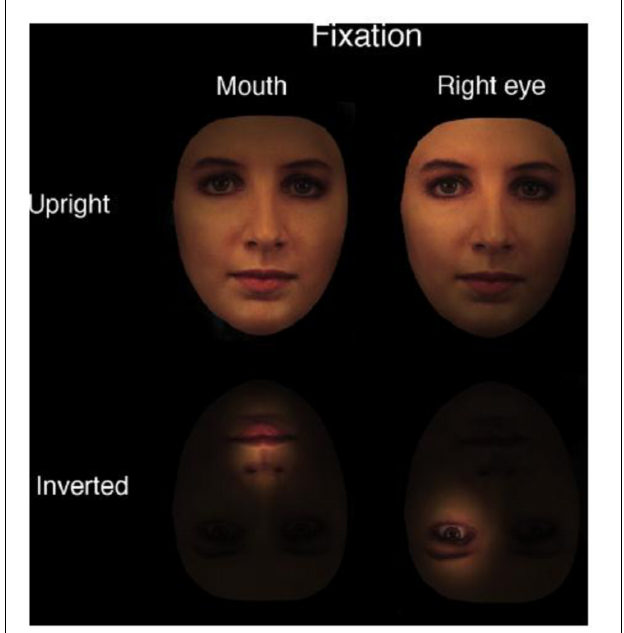
FIGURE 1 | According to the perceptual field hypothesis, an upright face is perceived as an integrated, whole face, rather than a collection of local features due to an expanded perceptual field that encompasses the entire face (upper left quadrant). In contrast, an inverted face is perceived as a collection of local features, rather than an integrated, whole face, due to the contraction of the perceptual field (adapted from Rossion, 2009, with